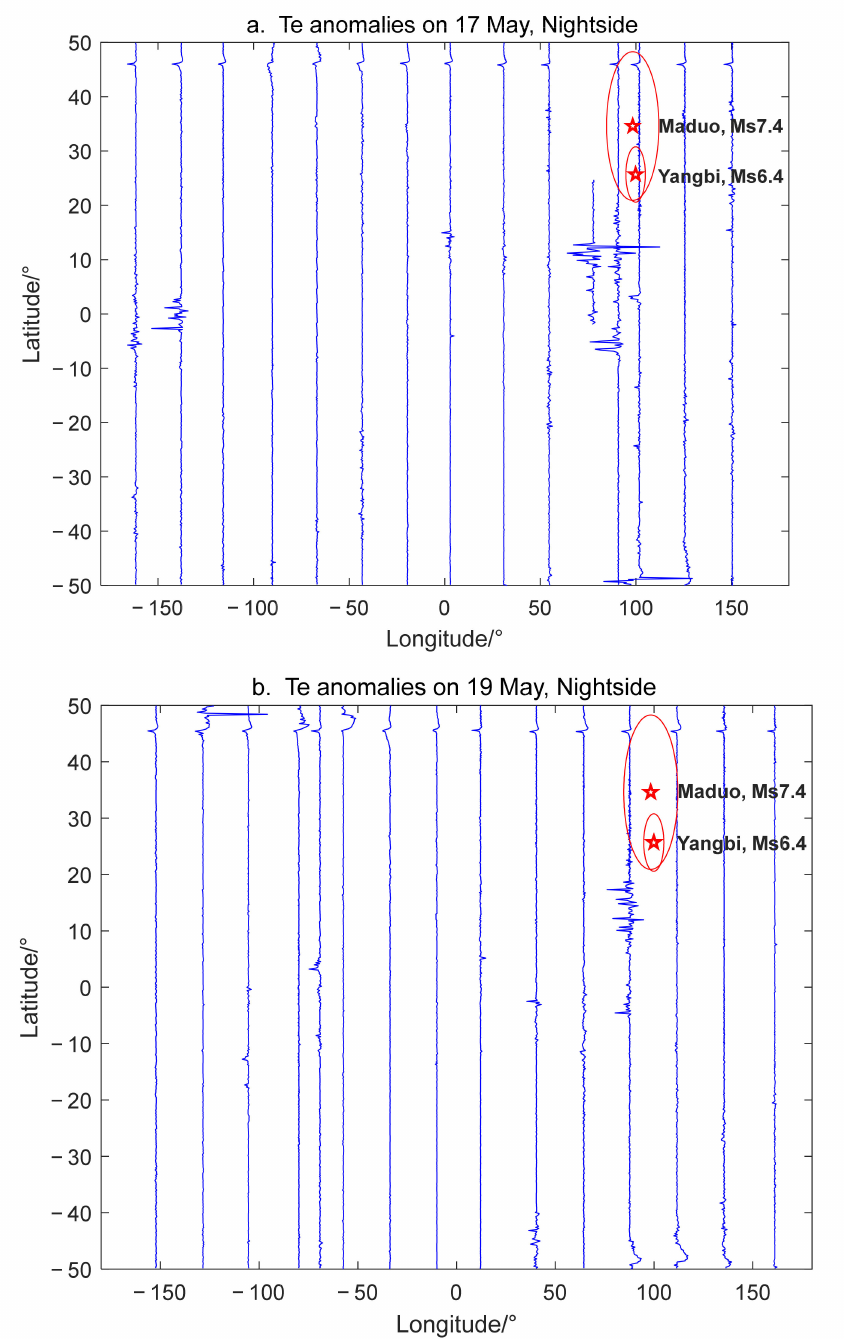
Figure 5. The global distribution of Te anomalies. The subfigure ( a , b ) represent the results of neightside on 17 May and 19 May, respectively. In each subfigures ( a , b ), the red stars and circles are epicenters and the seismogenic zones, the lower red star is Yangbi, and the upper one is